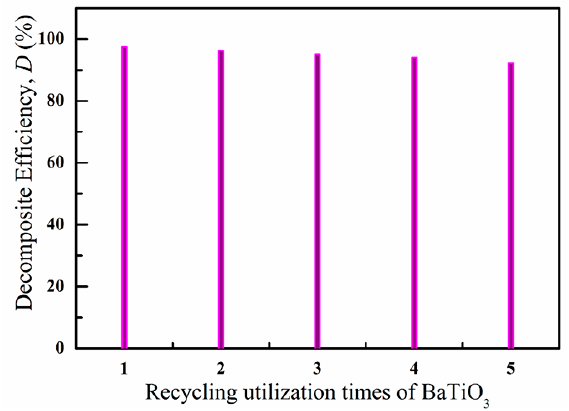
Figure 8. Recycling utilization of pyro ‐ electro ‐ catalytic BaTiO 3 nanofibers.